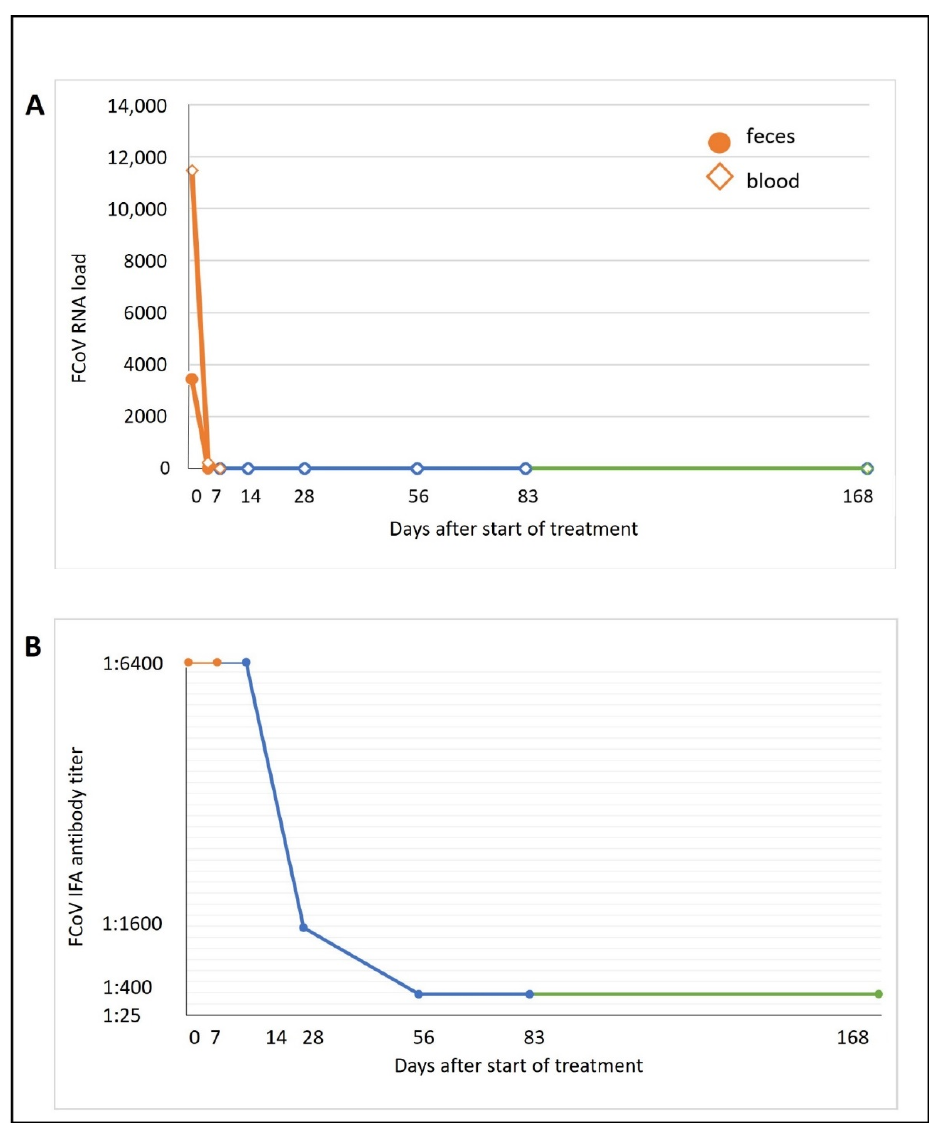
Figure 4. Feline coronavirus (FCoV) viral RNA loads in blood and fecal samples and serum anti-FCoV antibody titer. Lines are colored according to the different study sections: orange, hospitalization in the clinic (days 0–7); blue, recheck visits during treatment (days 14, 28, 56, 83); green, follow-up period at the end of treatment. ( A ) FCoV RNA loads in ethylenediaminetetraacetic acid (EDTA)- anticoagulated blood (presented in copy numbers/mL) and feces (presented in copy numbers/g). FCoV RNA loads were determined by quantitative reverse transcription polymerase chain reaction (RT-qPCR). Dot, feces; rhombus, blood. ( B ). Serum anti-FCoV antibody titer. Antibody titer was determined via indirect immunofluorescence assay